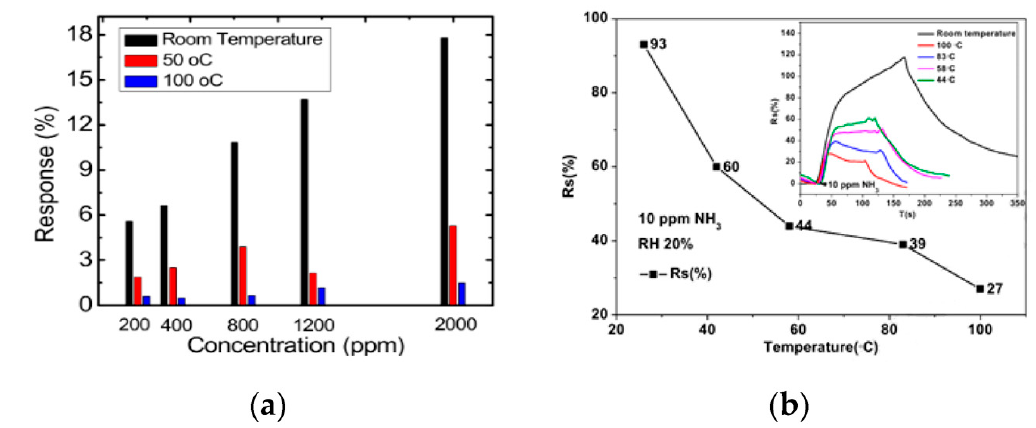
Figure 12. ( a ) Effect of operation temperature on the response of chemically reduced GO [67]. Reprinted (adapted) with permission from (Ghosh, R.; Midya, A.; Santra, S.; Ray, S. K.; Guha, P. K. Chemically reduced graphene oxide for ammonia detection at room temperature. ACS Appl. Mater. Interfaces 2013 , 5, 7599–7603.). Copyright (2021) American Chemical Society. ( b ) Variation of response of rGO/WS 2 hybrid sensor at 10 ppm NH 3 depending on the temperature [176]. With the permission of